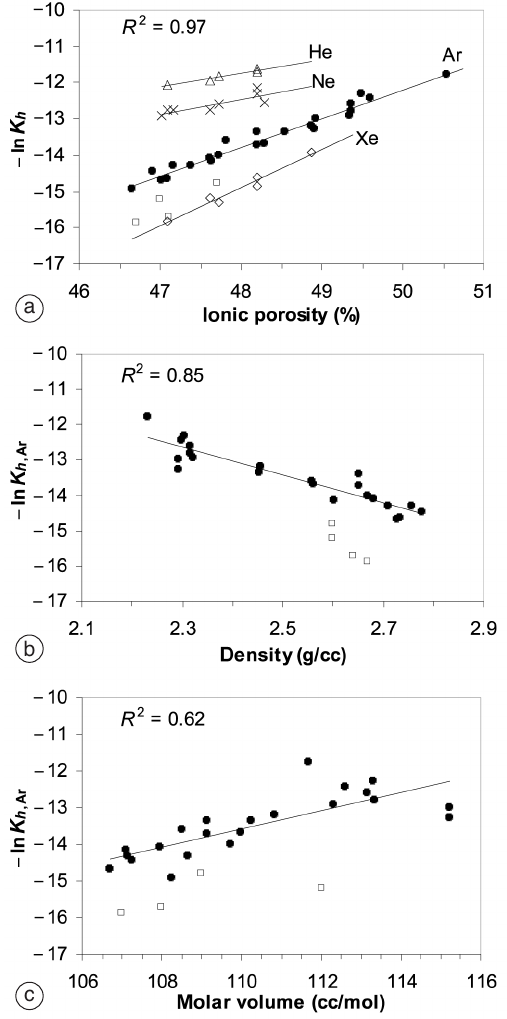
Fig. 7a-c. Relationships between noble gas solubil- ity and a) ionic porosity of melt, b) melt density and c) melt molar volume (modified from Carroll and Stolper, 1993). In all the graphs, the squares are sol- ubilities in CaO-MgO-Al 2 O 3 -SiO 2 (CAMS) melts from Broadhurst et al . (1992). Henry’s constant and molar volumes were computed on eight-oxygen ba- sis melts. Linear fits of data, with the related R 2 val- ues for Ar, are also displayed. Solubilities are much better correlated to ionic porosity than other parame- ters. The anomalous behavior of CAMS melts is un- clear (see text for